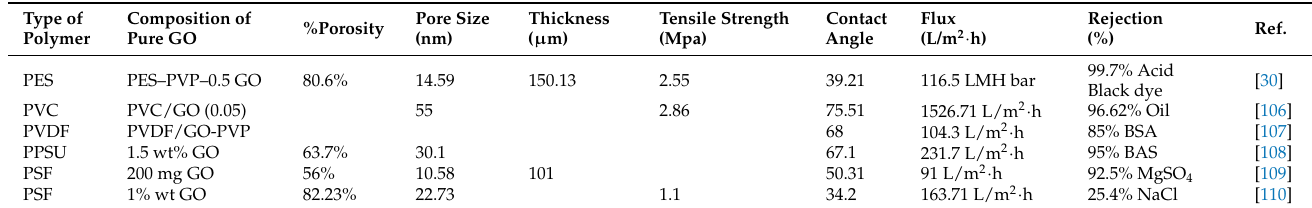
Table 3. Type of polymers with pure GO